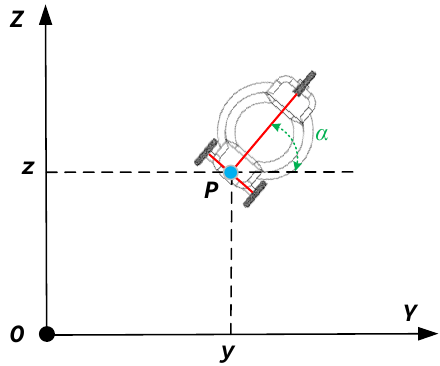
Figure 3. The coordinate system for WMR.